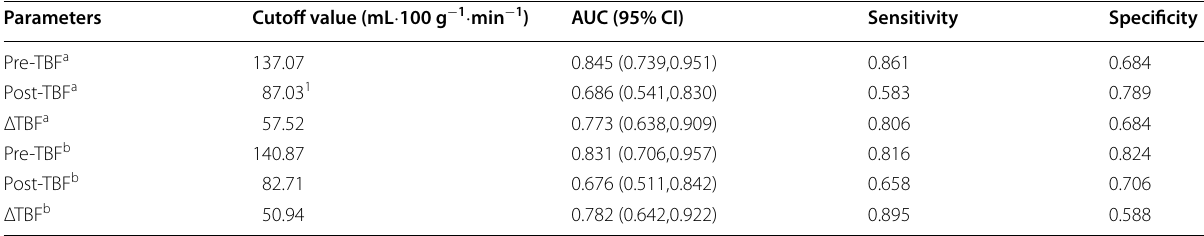
PR the partial response group; SD the stable disease group; Pre-TBF pre-treatment tumor blood flow; Post-TBF post-treatment tumor blood flow; ΔTBF changes in tumor blood flow; AUC area under the curve; CI confidence interval a the PR group and the SD group b